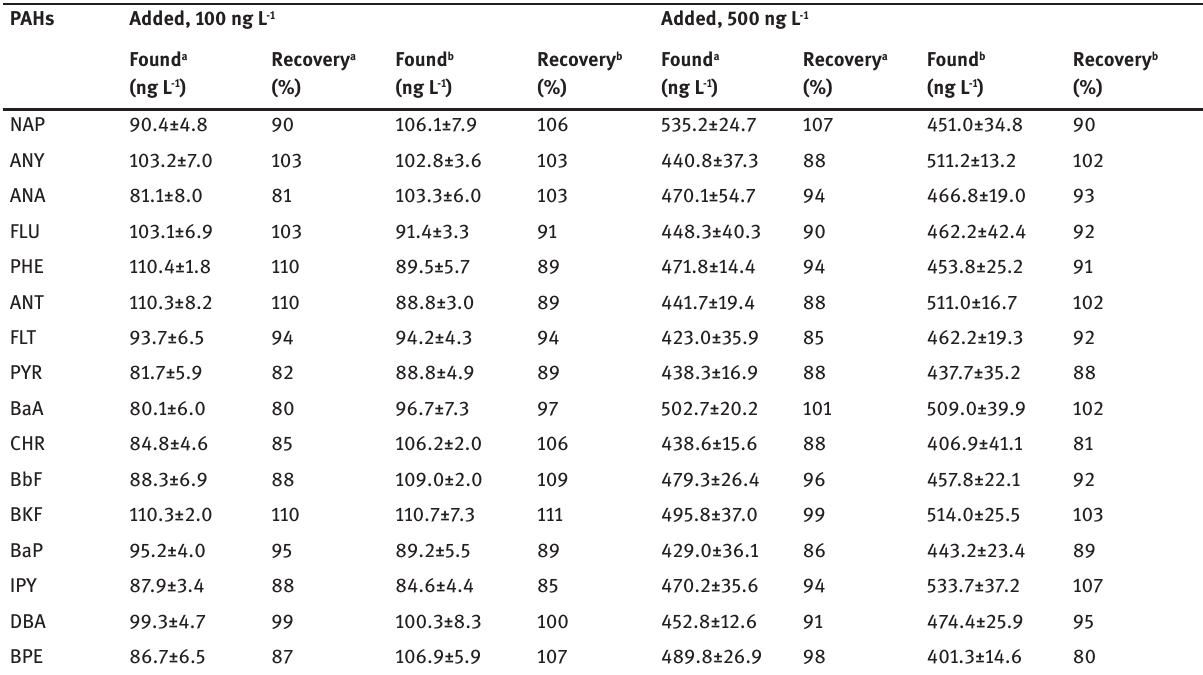
Table 2: Analytical performances of the developed method. PAHs Added, 100 ng L -1